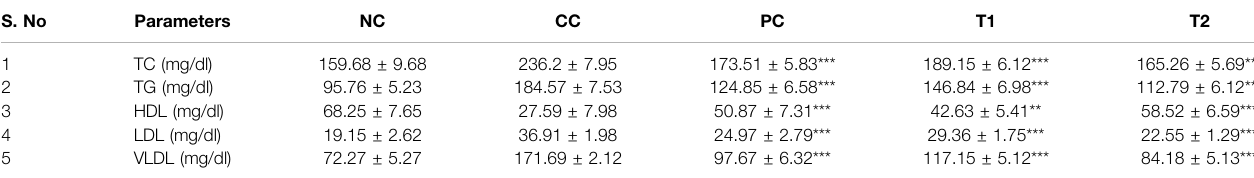
TABLE 2 | Rat serum lipid pro fi les were used to assess the effects of DEN and DI treatment (NC, Normal Control; CC, Carcinogen Control; PC, Positive Control; T1: DI (100 mg/kg) and T2: DI (200 mg/kg). S.